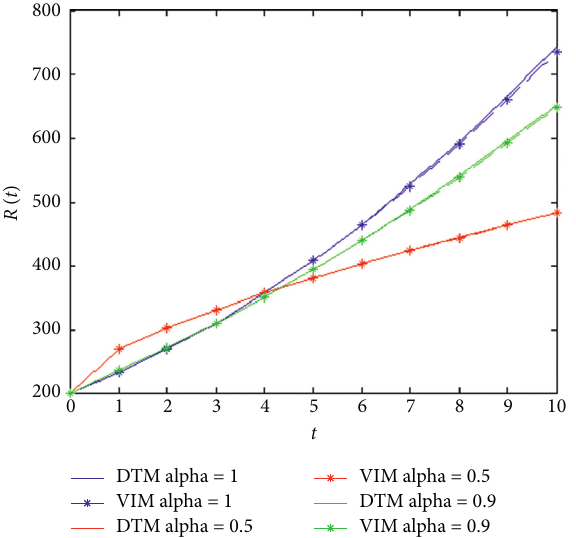
Figure 3: Comparison of VIM solutions with the CDTM solutions of R ( t ) for system (10) at different α